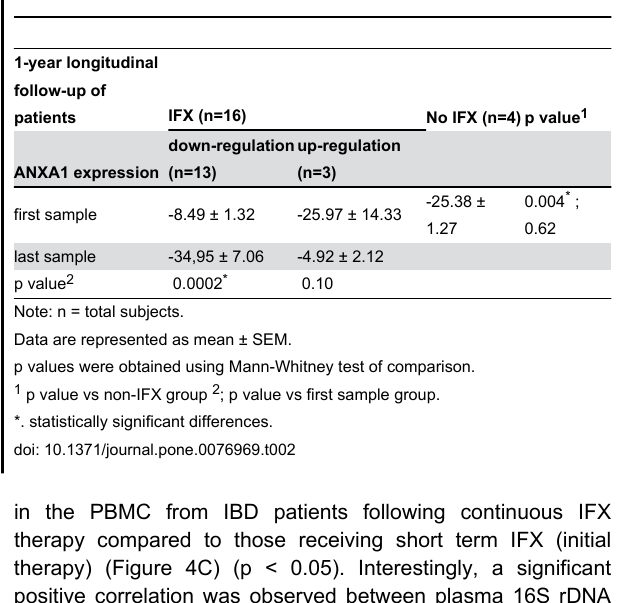
Table 2. Longitudinal follow-up of infliximab (IFX) treatment vs ANXA1 expression in IBD